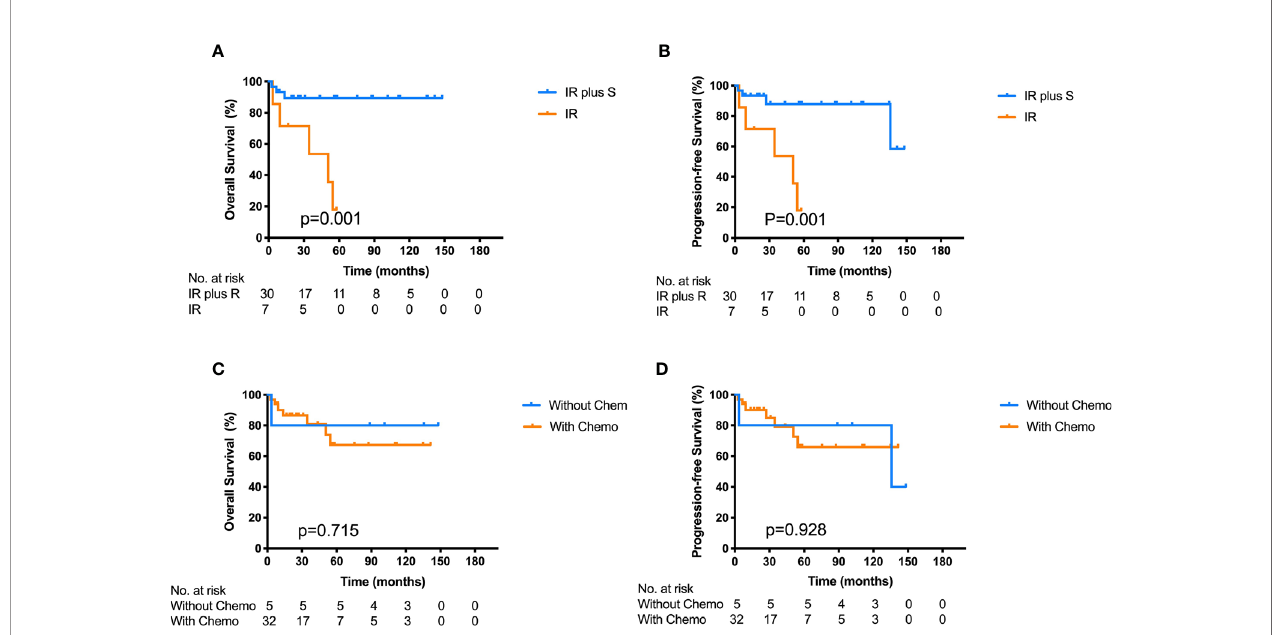
FIGURE 4 | Kaplan – Meier survival curves for overall survival (OS) (A) and progression-free survival (PFS) (B) of the 37 ONB patients with frontal lobe invasion strati fi ed by IR plus S vs. IR. Log-rank tests show that the combination of IR and S has better OS (p = 0.001) and PFS (p = 0.001) than IR alone. Kaplan – Meier survival curves for OS (C) and PFS (D) of the 37 ONB patients according to chemotherapy (without Chemo vs. with Chemo). Log-rank test shows no signi fi cant differences between the two groups. IR, irradiation therapy; S, surgery; Chemo,